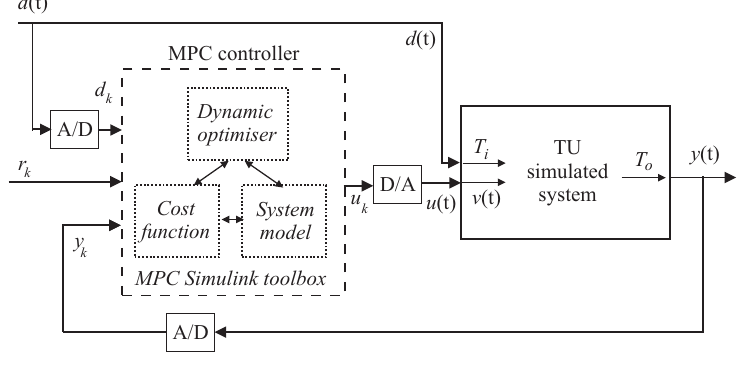
Figure 12. Diagram of the TU system controlled by the MPC scheme.